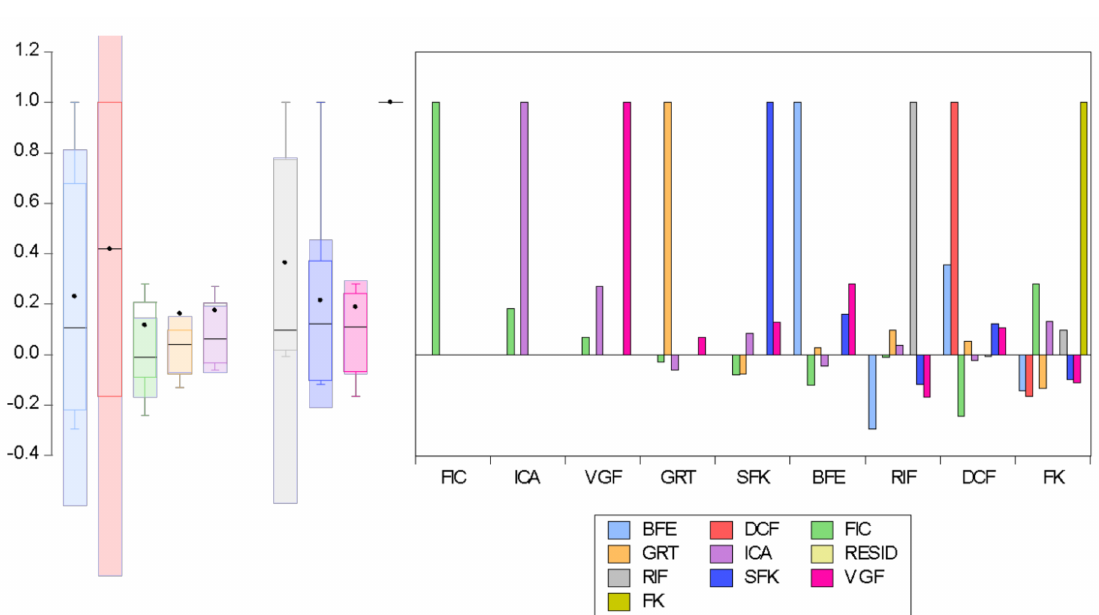
Figure 7. Box-auto correlation analysis between the